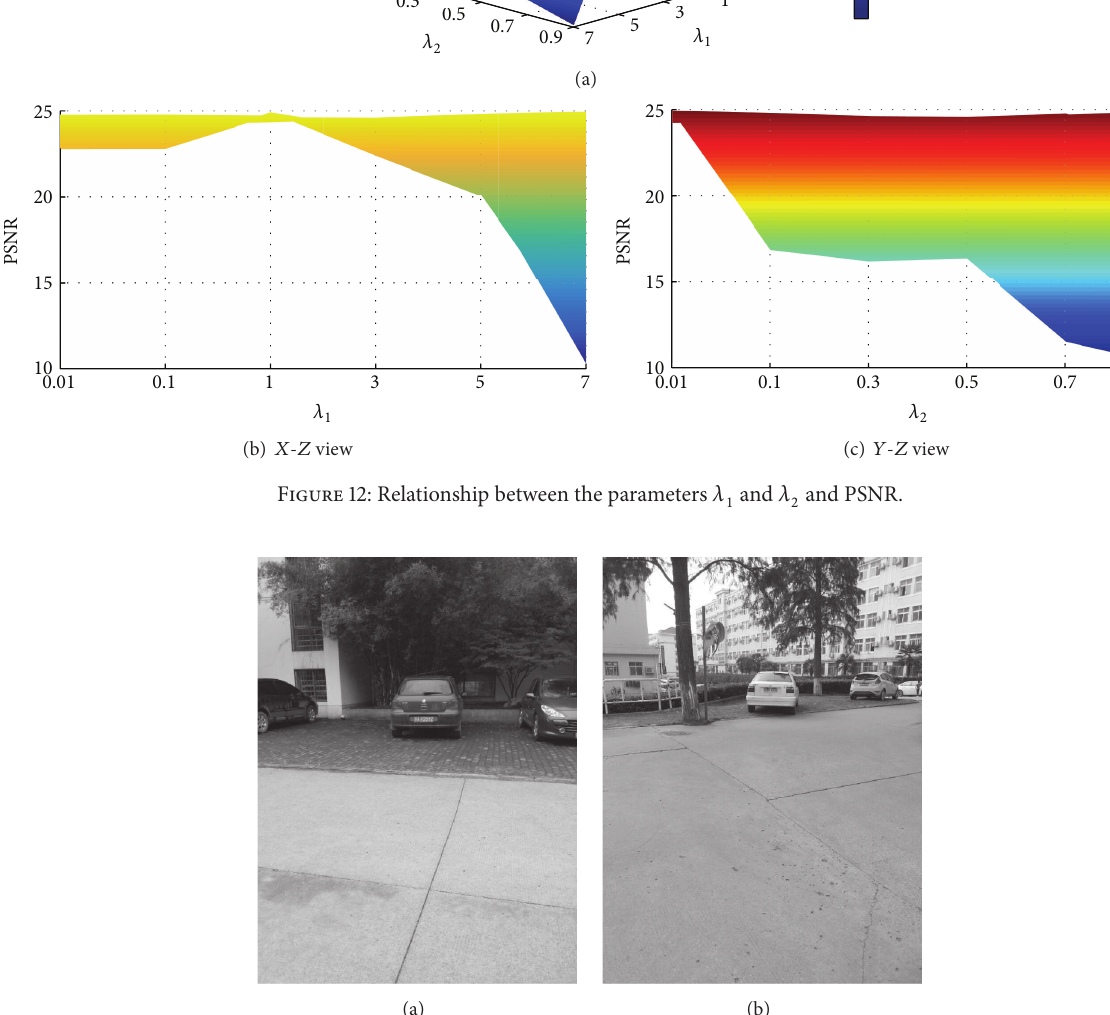
in enhancing LR frames captured from real traffic could be demonstrated by using the experiments described